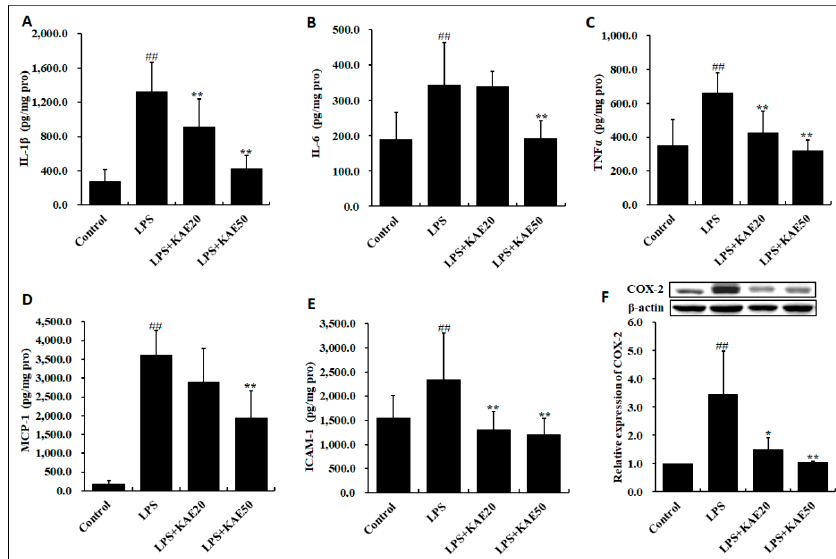
Figure 4. Effect of kaempferol on pro ‐ inflammatory factors and chemokines in the striatum of mice injured by LPS. ( A ) interleukin 1 β (IL ‐ 1 β ); ( B ) interleukin 6 (IL ‐ 6); ( C ) tumor necrosis factor α (TNF ‐ α ); ( D ) monocyte chemotactic protein ‐ 1 (MCP ‐ 1); ( E ) intercellular adhesion molecule ‐ 1 (ICAM ‐ 1); and, ( F ) cyclooxygenase ‐ 2 (COX ‐ 2). Values are expressed as mean ±SD ( n = 8). ## p < 0.01 vs. Control group. * p < 0.05, ** p < 0.01 vs. LPS group.